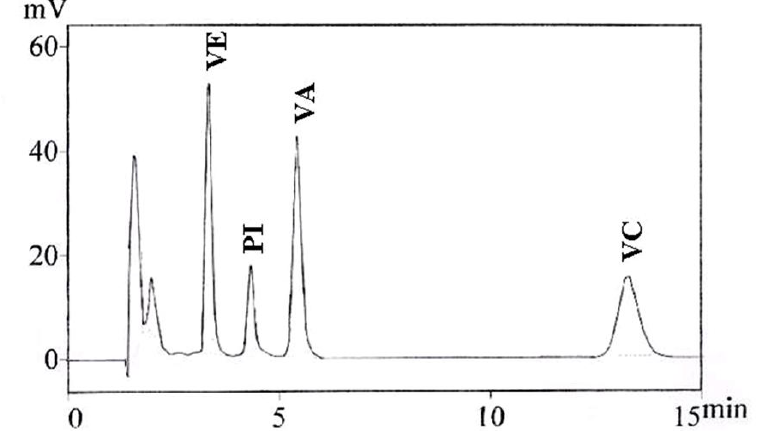
Figure 3. HPLC chromatograms of vitamin E (VE), A (VA) and C (VC) derivatives extracted from the gel-cream formulation in concentration of 250  g/mL, with Vitamin K1 (PI) as an internal standard.